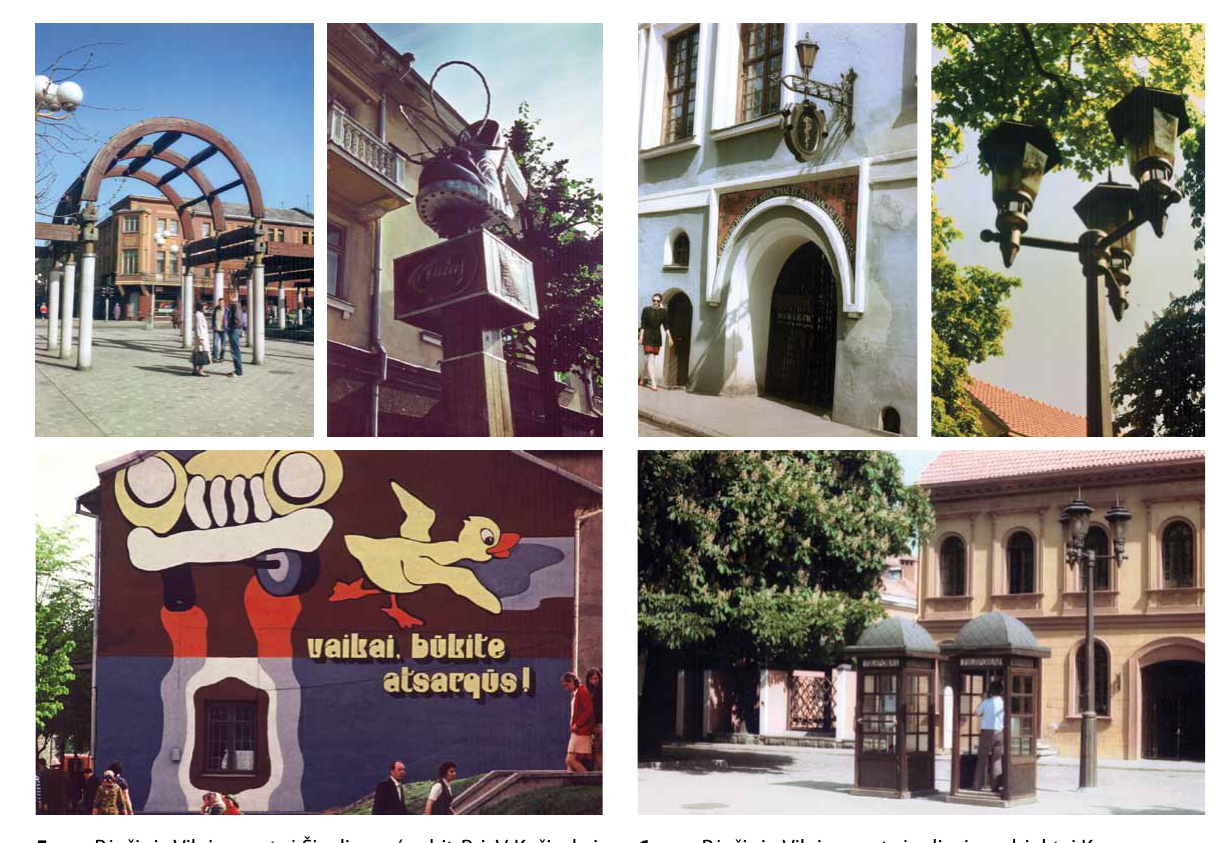
Fig. 5. Pedestrian Vilniaus street in Šiauliai (architects r. and Fig. 6. Design objects of pedestrian Vilniaus street in the old Town of Kaunas (architects r. Palis and r.